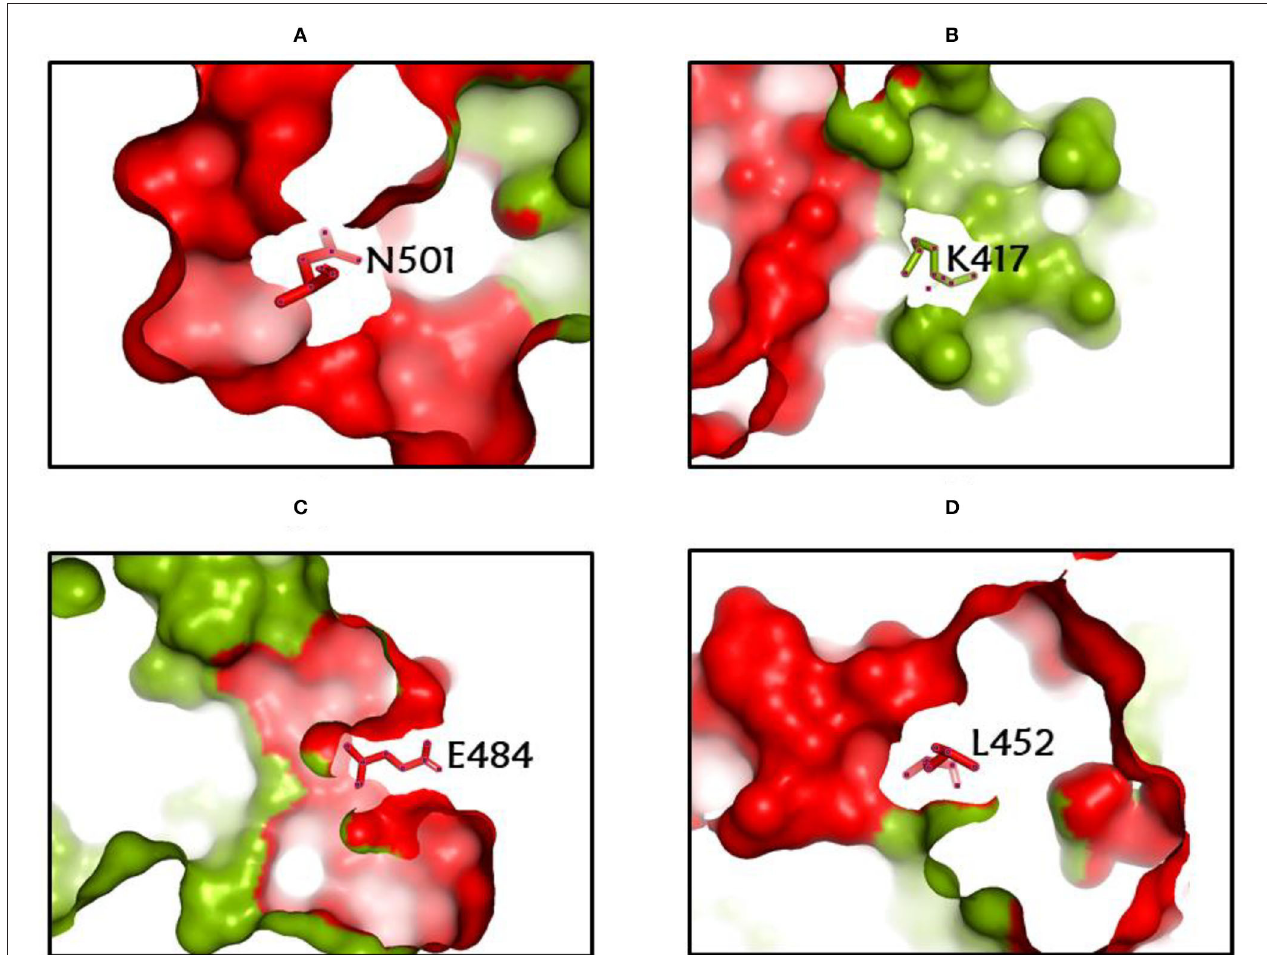
FIGURE 2 | (A-D) The most common spike glycoprotein residues (N501, K417, E484, L452), where diverse mutations occur, resulting in different SARS-CoV-2 VOCs, VOIs, and